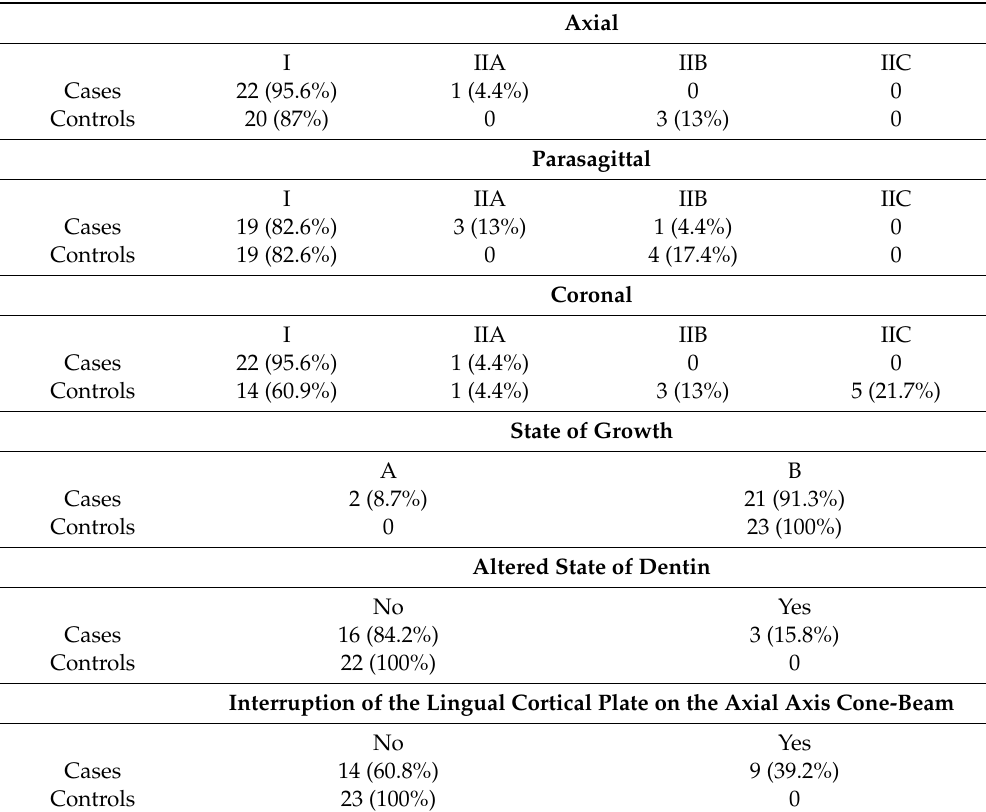
Table 1. Results associations between OI and healthy